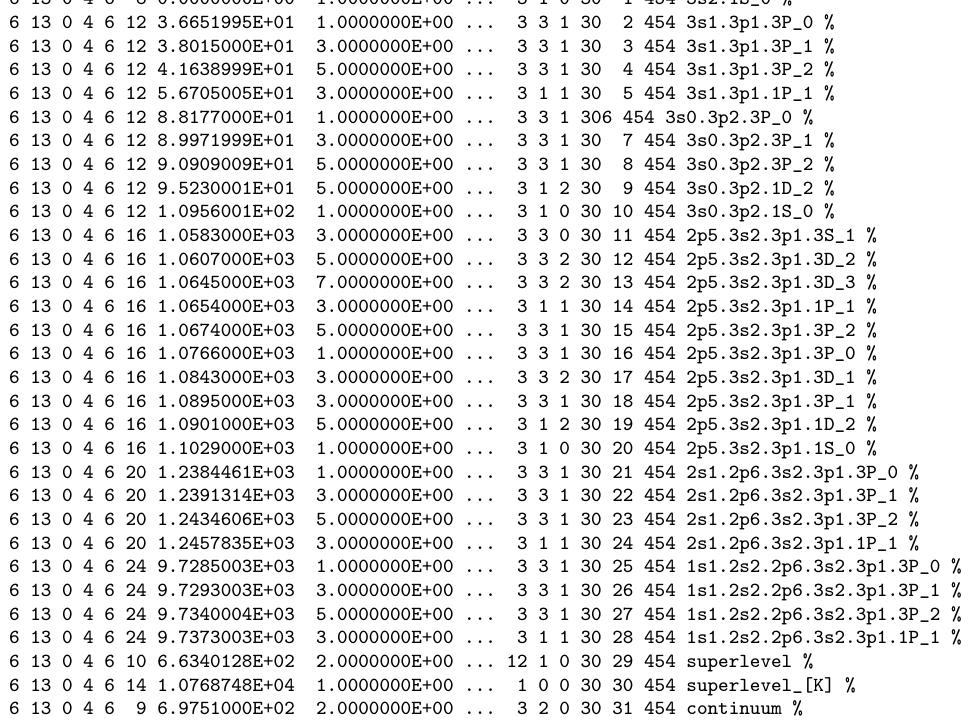
Figure 2. Content of file d 454 t 006 of the XSTAR database listing the atomic model (data type dt = 06 and rate type rt = 13) for Mg-like Zn XIX ( ion =